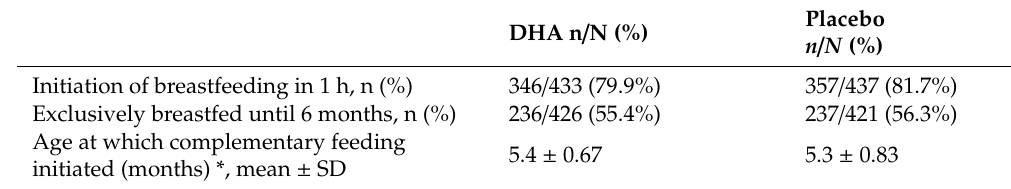
Table 3. Feeding